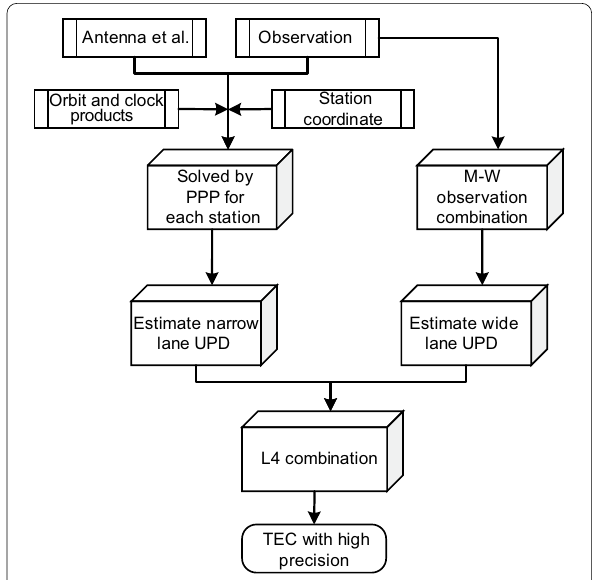
Fig. 1 Flow chart of ionospheric delay estimated by using the PPP-Fixed